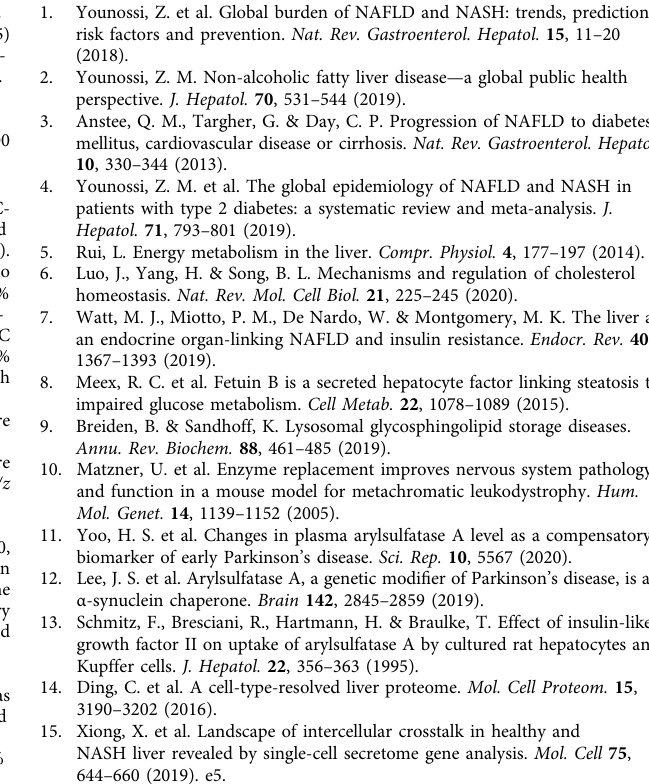
Table S12. Details on mass spectrometry platforms utilized in each proteomics and lipidomics experiment are detailed in Supplementary Table S13. All generated fi les were analyzed with MaxQuant (version 1.5.3.30) 69 and its implemented Andromeda search engine to obtain protein identi fi cations as well as their label-free quantitation (LFQ) intensities. Database searching was performed with the following parameters: cysteine carbamidomethylation as a fi xed modi fi cation; up to 2 missed cleavages permitted; mass tolerance of 20 ppm; 1% protein false discovery rate (FDR) for protein and peptide identi fi cation;